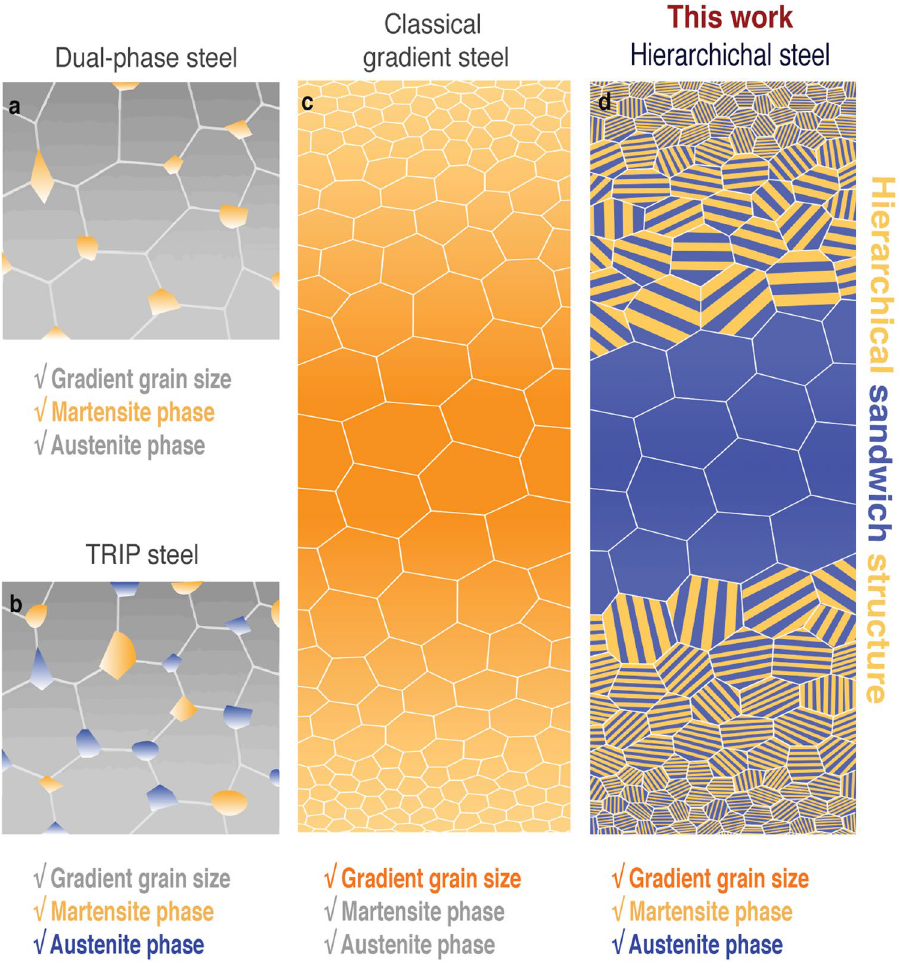
Figure 2. The overall structure of the hierarchical steel as compared to that of other strong and tough steels. ( a ) Schematic illustrations of the microstructure of a dual-phase steel showing the martensite phase (yellow lumps) randomly embedded in the ferrite matrix. ( b ) TRIP steel showing the martensite (yellow lumps) and austenite (blue plates) phases embedded in the ferrite matrix; note that there are no gradient structures in either the dual-phase or TRIP steels. ( c) classical gradient steel displaying a traditional gradient in grain size. ( d) our hierarchical steel showing a sandwich structure of nano-scale dual-phase (martensite and austenite) in the surface region (extending some 300 µ m from the surface) with a coarser-grained austenitic region in the core of the